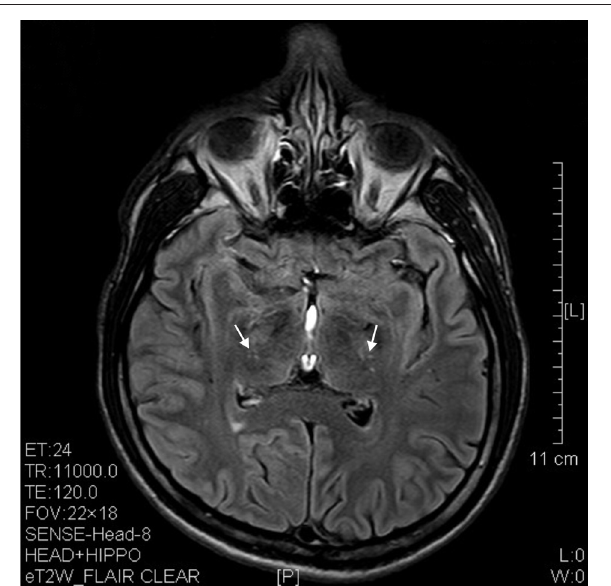
FIGURE 6 | T2 image showed hypertensive degenerative spots in corpus striatum (arrows) of a 6 years’ ketamine addicts.